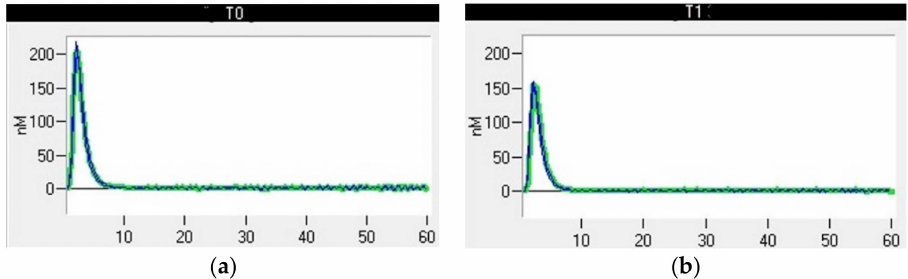
Figure 5. Thrombin generation curve of a dog after bilateral maxillectomy for osteosarcoma. ( a ) T0, thromboelastometric tracing performed with blood samples collected before surgery; ( b ) T1, throm- boelastometric tracing with blood collected 24 h after